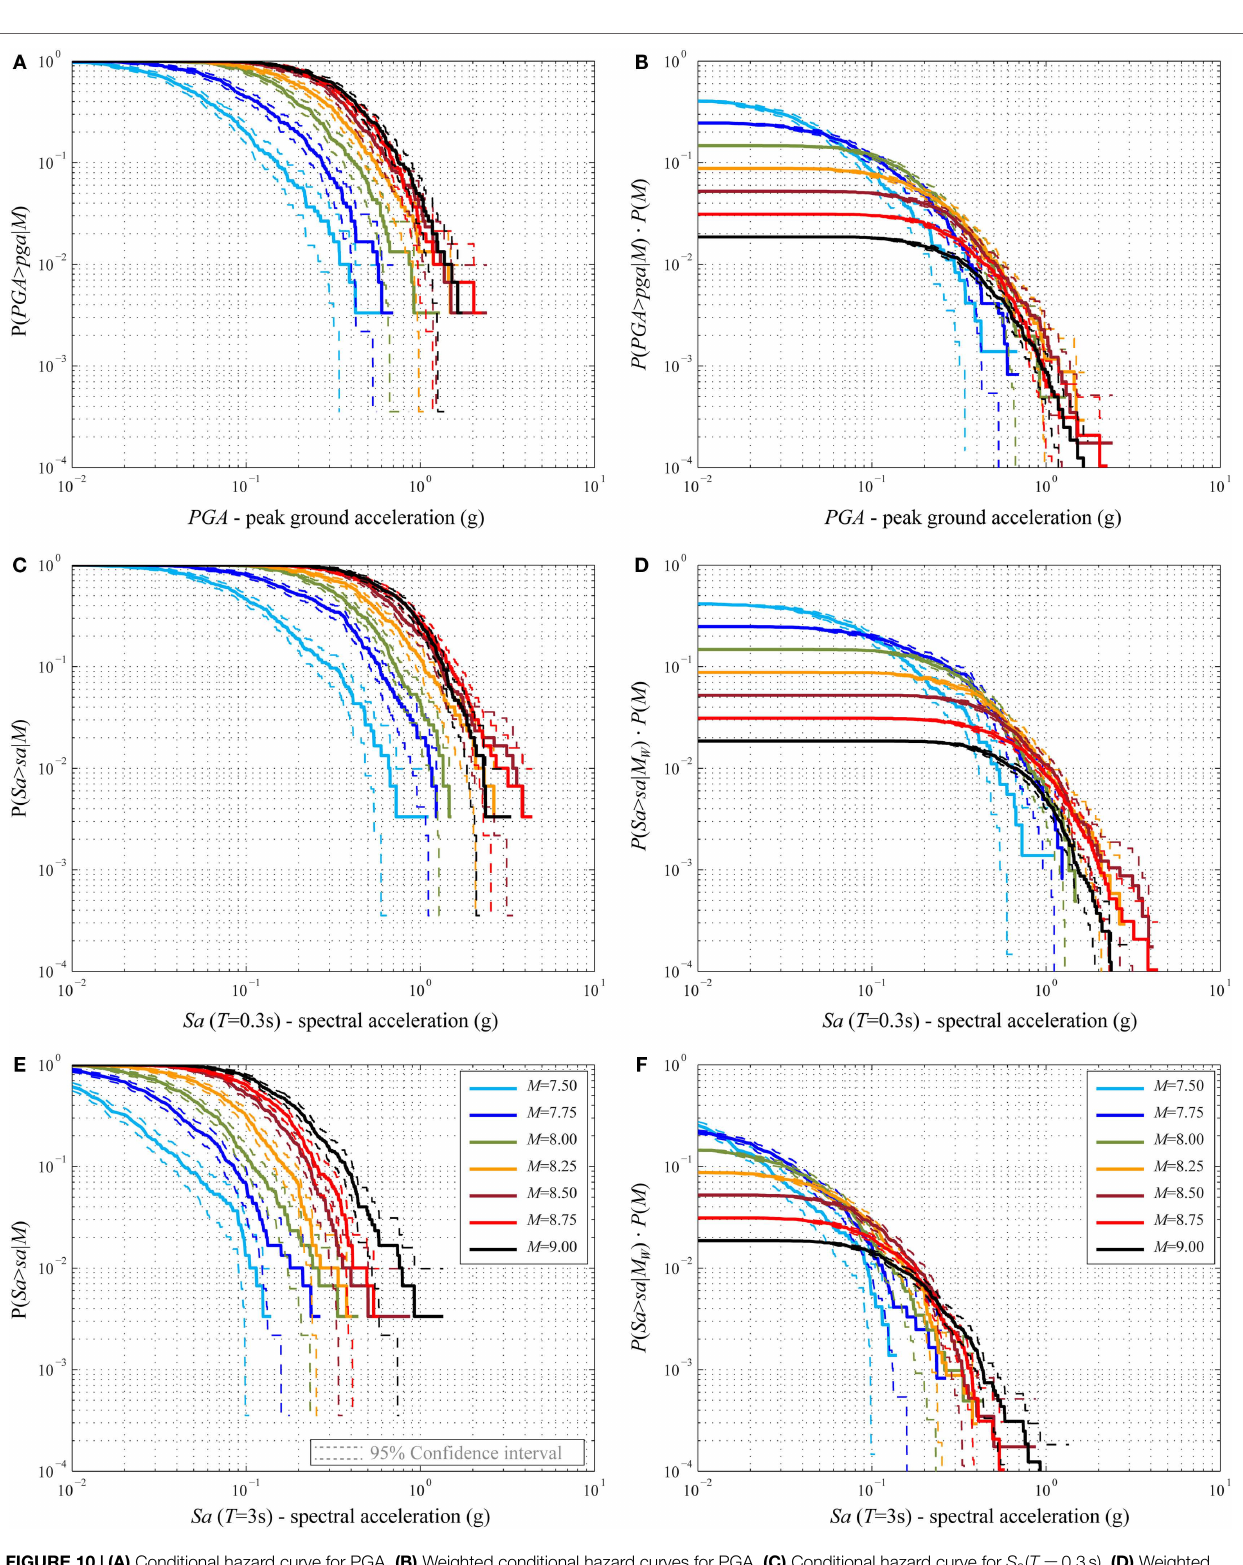
Frontiers in Built Environment |